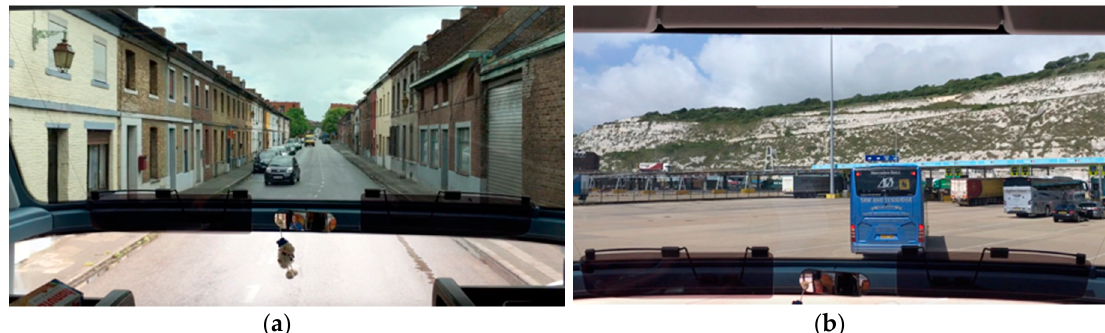
Figure 4. Conrad Risch, Jonathan Schmalöer: A Bus Ride to Utopia: ( a ) Approaching Le Grand Hornu; ( b ) Arrival in